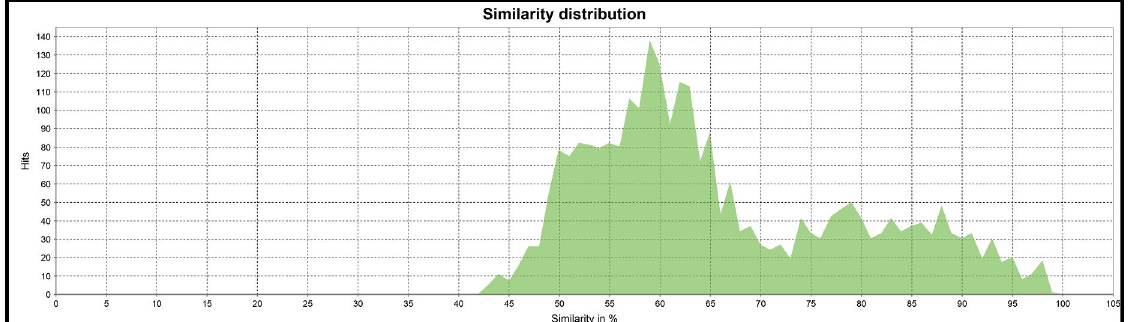
Figure S4 : Average similarity value distribution of the best 20 hitsof the 140 EST-Contigs submitted to BlastX by